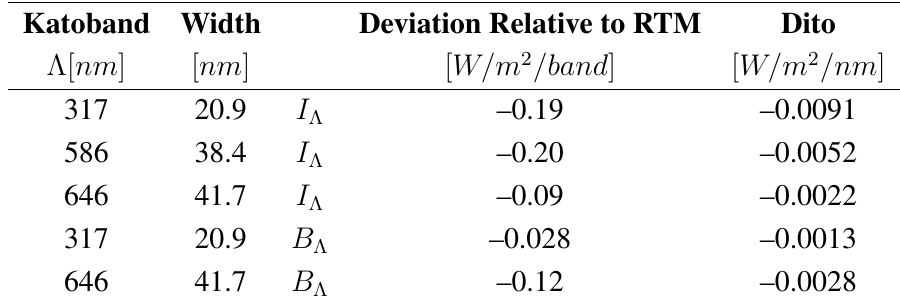
Table 2. Comparison of irradiance calculated with either RTM or the parameterization given in Equation (5). Values are given for three ozone bands calculated with high SZA of 80 ◦